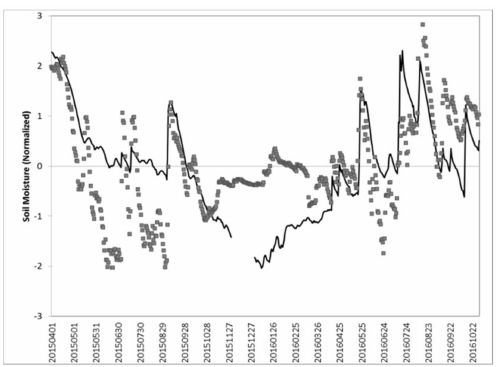
Figure 4. Time series of normalized root zone soil moisture from SMAP modelled data sets for sites in Ontario ( Top Left ), Manitoba ( Right ) and Alberta (Wrentham site, Bottom Left ). Soil moisture was normalized for each data set to compare data sets as indicators of relative trends. The Alberta Wrentham site was selected for display as it represented average results for Alberta.